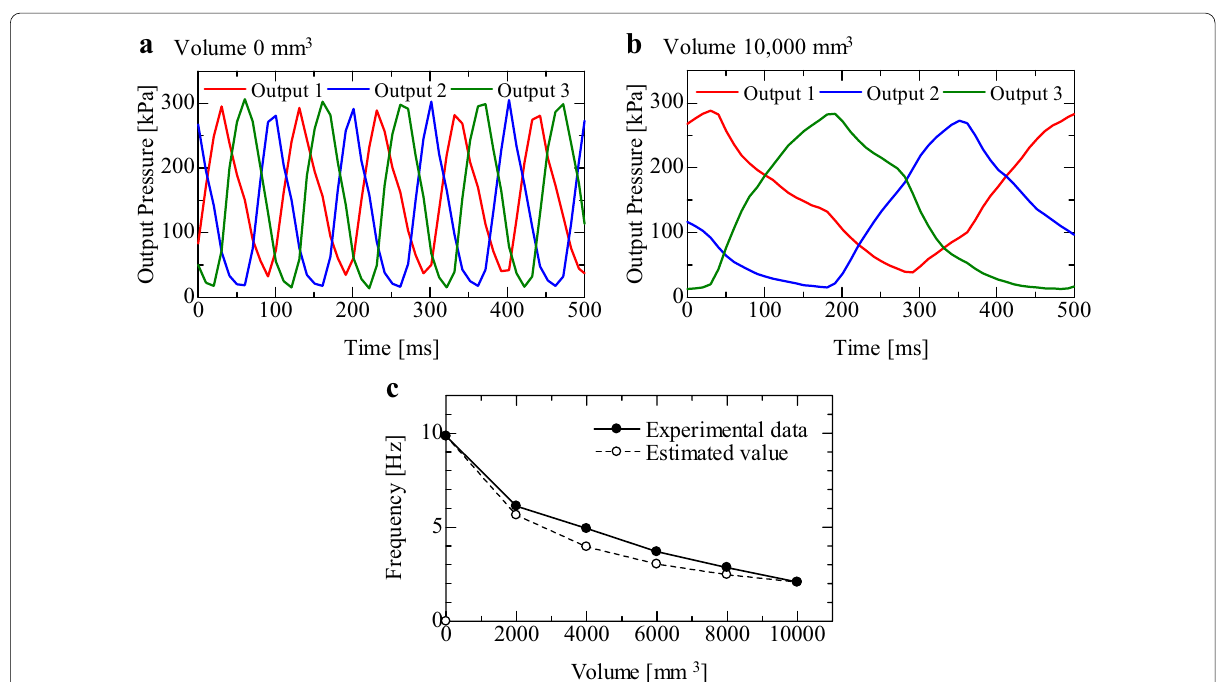
Fig. 9 Frequencies affected by the volume of the chambers. a Volume of the attached chamber is 0mm 3 . b Volume of the attached chamber is 10,000mm 3 . c Relationship between the volume of the attached air chambers and frequency of self-excitation